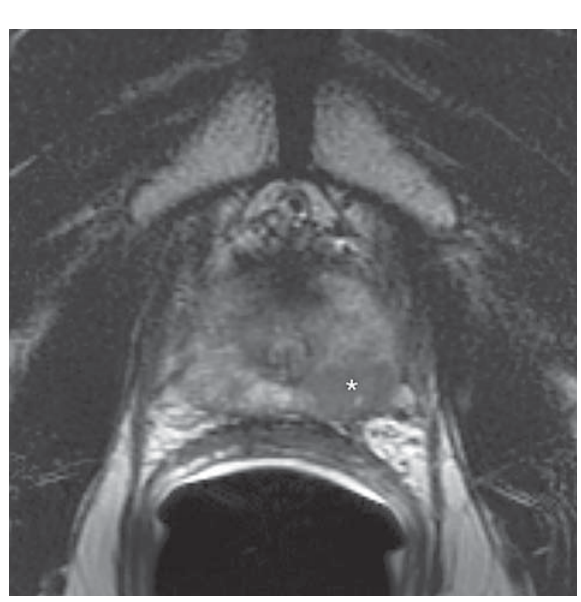
Figure 2 – 63 year-old man with biopsy-proven recurrence of prostate cancer in the right mid-gland and base 4 years and 2 months after treatment. Axial T2-weighted image (TE/TR 5000/96) shows diffuse low signal intensity in the peripheral zone and cen- tral gland. Both readers interpreted it as a negative